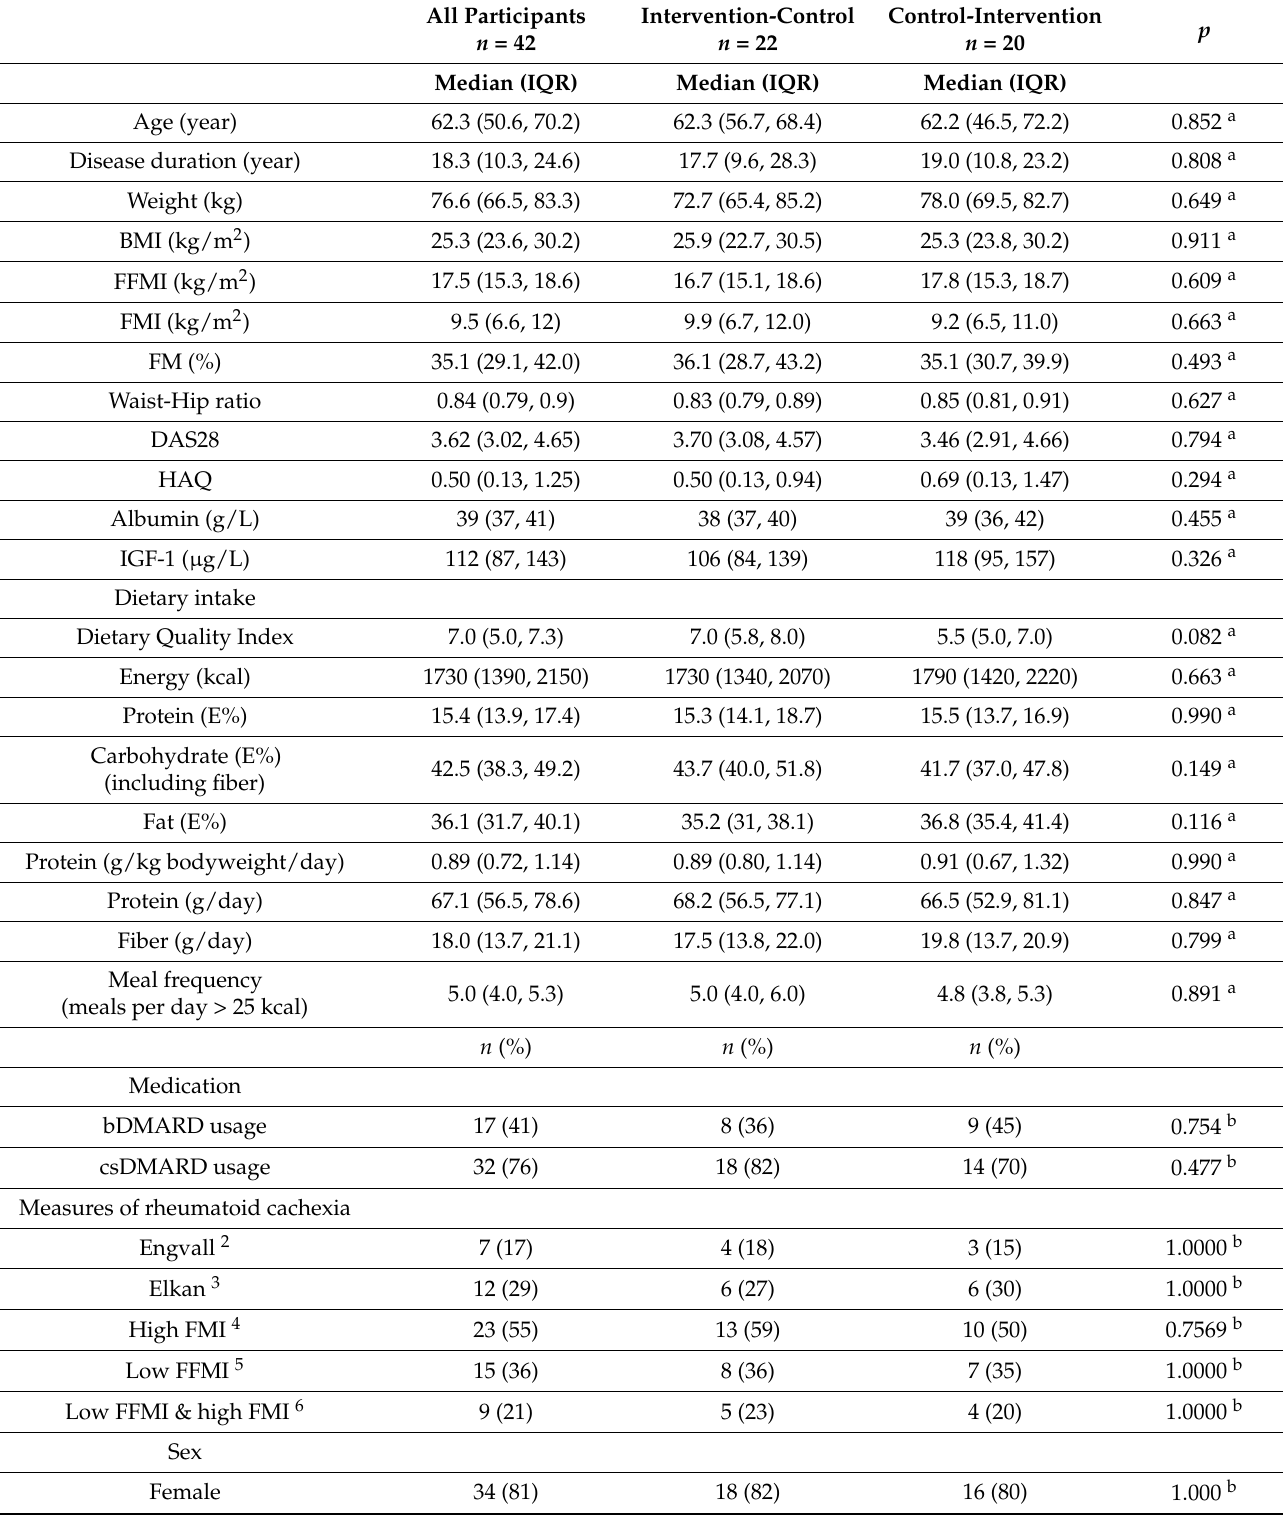
Table 1. Baseline data of participants who completed at least one diet period, stratified by sequence according to the CONSORT